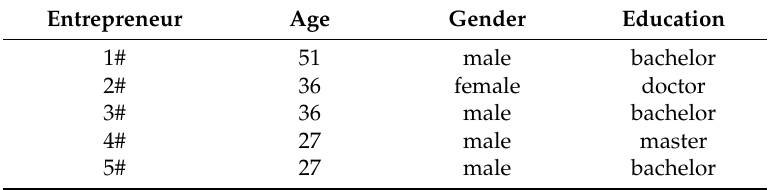
Table 3. Basic Information of